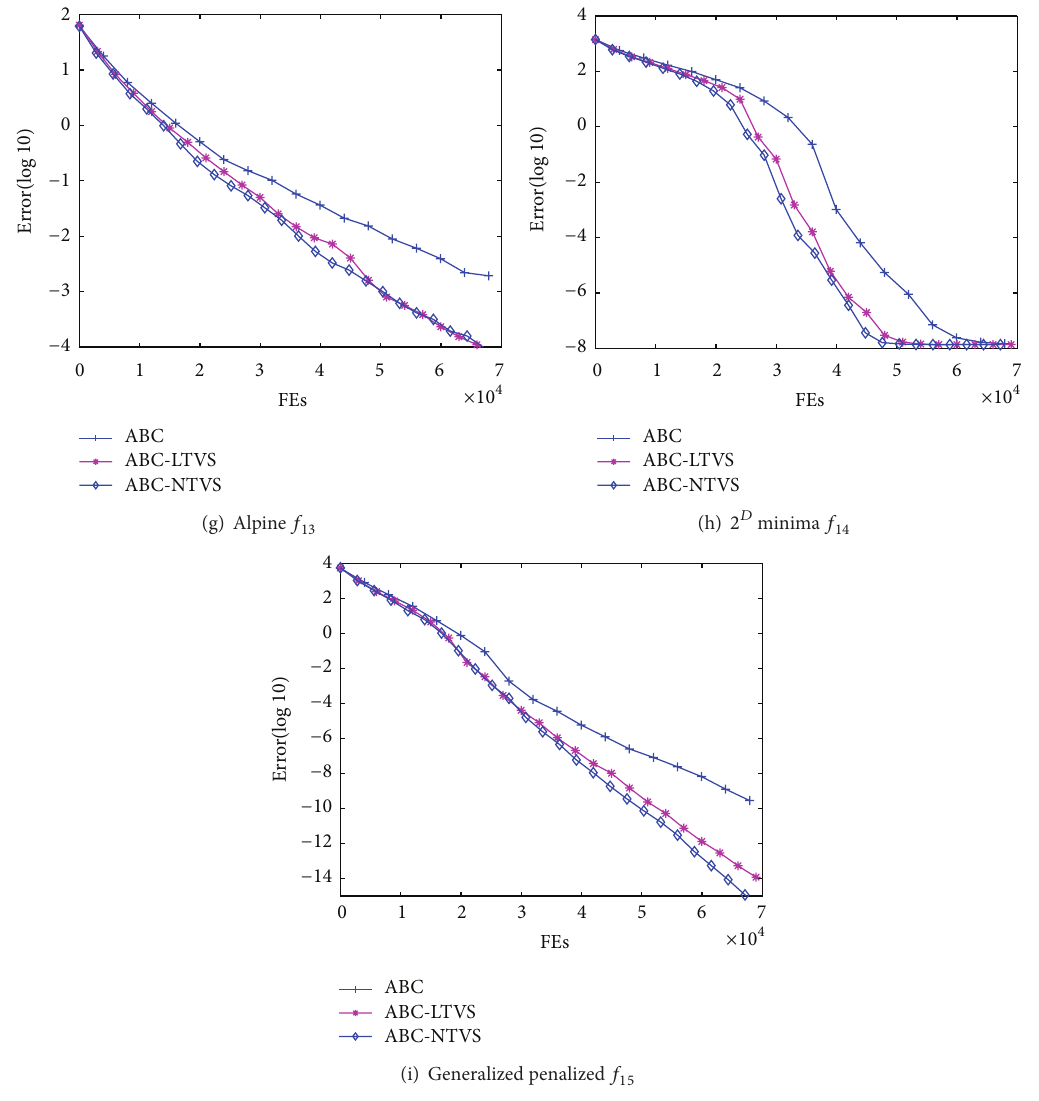
Figure 5: Convergence curves of ABC variants solving multimodal functions 𝑓 7 – 𝑓 15